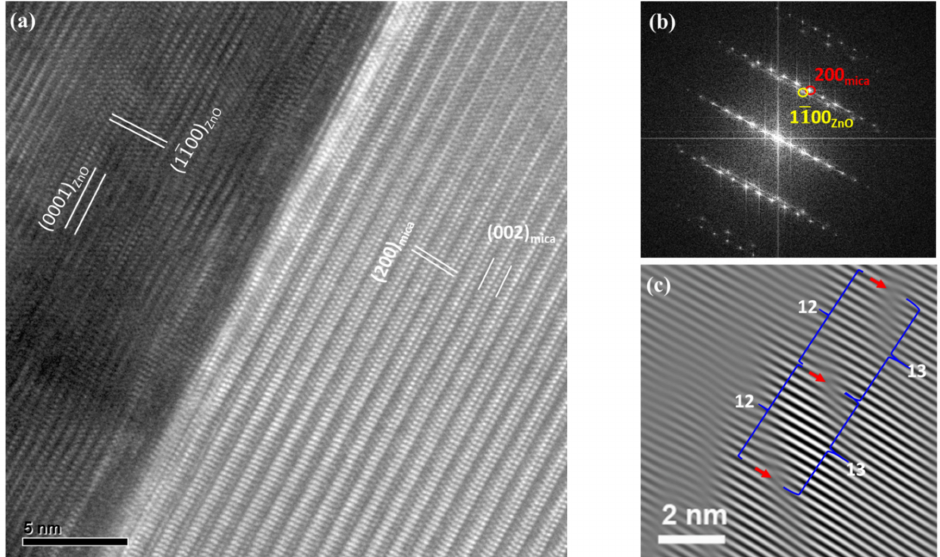
Figure 6. ( a ) HRTEM image of the ZnO layer–mica substrate interface viewed along the mica [10] zone axis. ( b ) Corresponding FFT pattern of ( a ). ( c ) Fourier-filtered image reconstructed utilizing ZnO 1100 and mica 200 reflections. The black triangles in the Fourier-filtered image indicate the position of misfit dislocation.